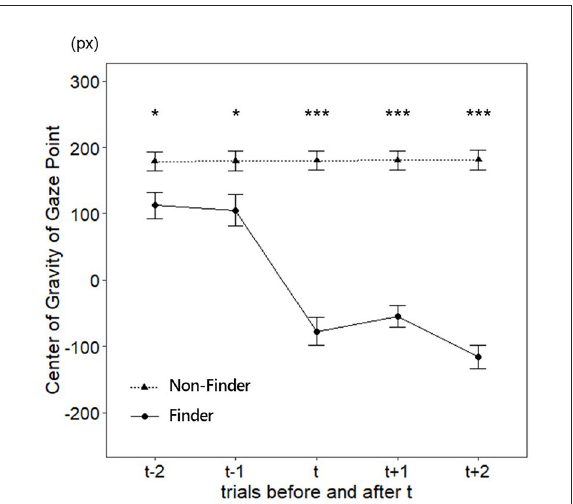
FIGURE5 The center of gravity of the gaze point during the five trials around the finding reporting trial t (Right end = 640, Center = 0, Left end = − 640). Error bars are SE . *** p < 0.001, ** p < 0.01, * p < 0.05.